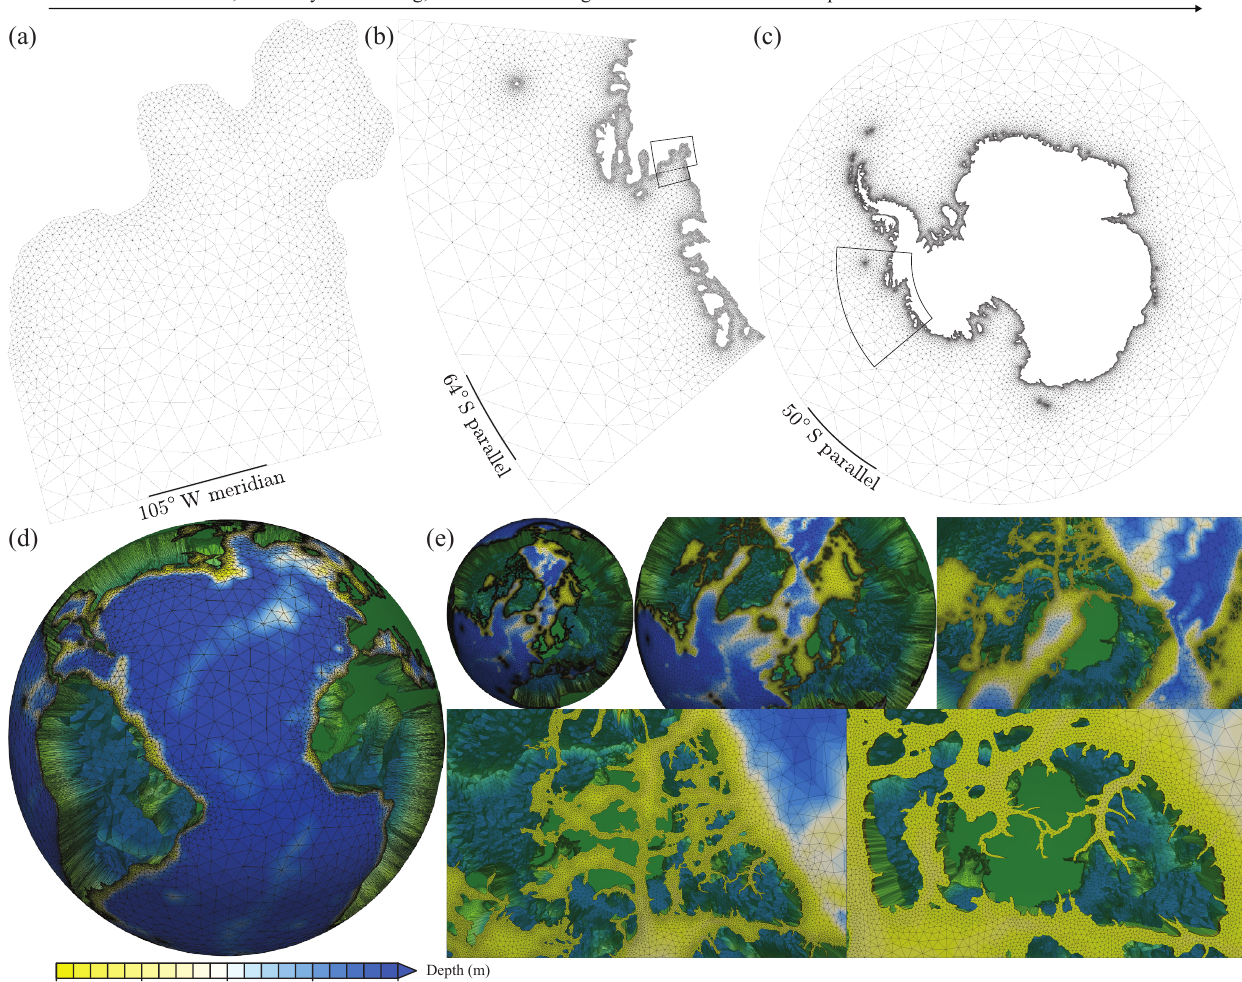
Figure 9. A selection of further example geophysical domain discretisations straightforwardly described in BRML and automatically con- structed using Shingle. (a) T h of the Pine Island Glacier ice shelf ocean cavity from the ice–bedrock grounding line extended out to the 105 ◦ W meridian. (b) The Amundsen Sea region in West Antarctica extended out to the 64 ◦ S parallel. (c) The Southern Ocean Antarctic continent landmasses, from the ice grounding line to the 50 ◦ S parallel, built from a high-fidelity boundary representation containing 348 automatically identified islands. (d) The full T of the global oceans, with a radial scaling of 300 to exaggerate the vertical extent of the discre- tised shell and land regions shaded in green. (e) Zoomed-in regions focusing on the complex Canadian Arctic Archipelago west of Greenland around Ellesmere and Baffin islands. (a) – (c) are generated from the GEBCO (2014) DEM and presented under a orthographic projection centred on 90 ◦ S, and (d) – (e) from RTopo (Timmermann et al., 2010) and viewed in a Cartesian frame. These contain a multi-scale of spatial resolutions, with element edge lengths parallel to the geoid in these examples, specified through M h , ranging from 2 to 500km. Vertical layers in (d) , specified through M v , vary from 2 to 500m, under differing regimes in a generalised hybrid coordinate system described fur- ther in Candy (2016), and leads to a mesh containing 8778728 elements and 35114912 spatial degrees of freedom under its discontinuous Galerkin finite element discretisation. Along with other examples presented in Fig. 1c–g, these are part of the test suite accompanying the